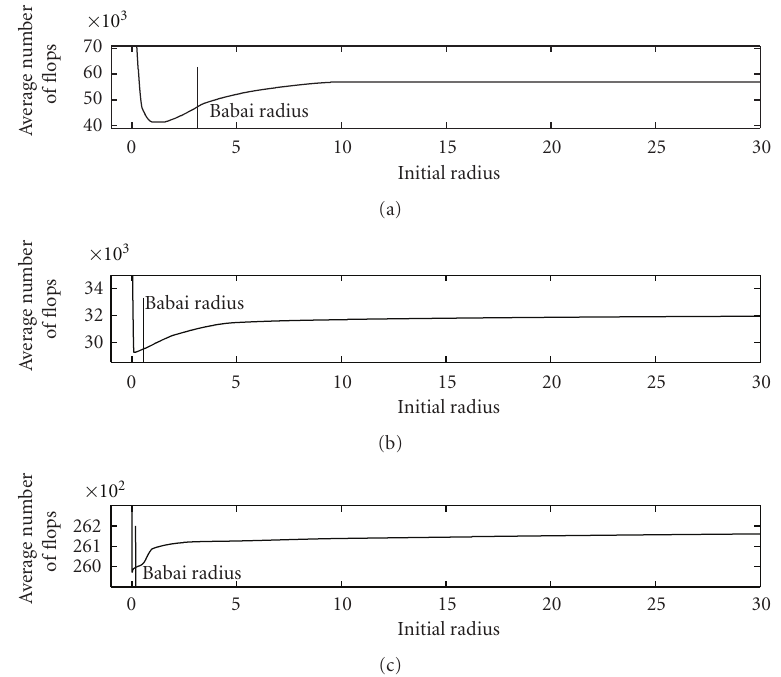
Figure 4: The average number of flops versus initial radius of SE-SD algorithm when P = 4 and M = 64. (a) σ 2 = 0 . 203 ( ρ = 18 . 4dB), (b) σ 2 = 0 . 056 ( ρ = 24dB), and (c) σ 2 = 0 . 014 ( ρ = 30dB).